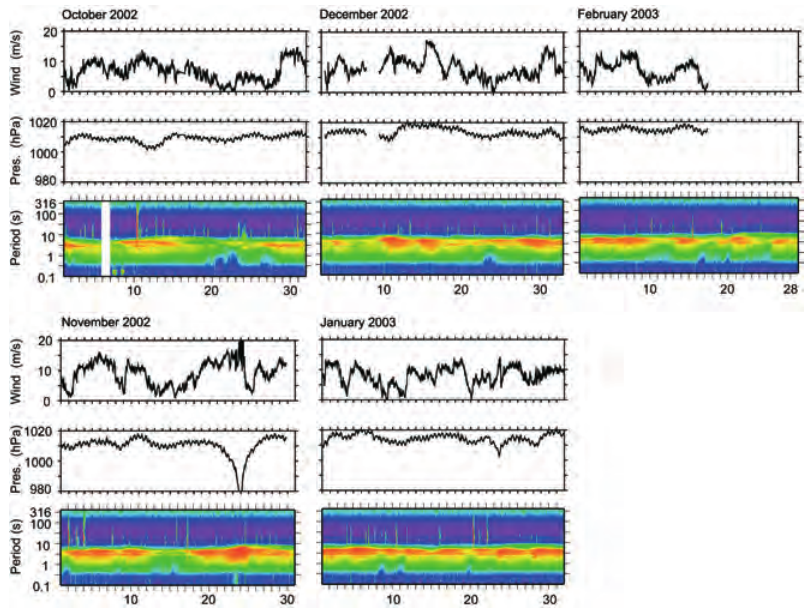
Fig. 9b. Comparison between the noise spectra of vertical component of the WP-1 and the meteorological da- ta (average wind speeds and air pressure) observed at Okinotori-shima, which lies about 150 km northeast of WP-1: from October 2002 to January 2003. Rapid decreases of air pressure indicates typhoon passing. The wind speed appears to be related to noise levels in periods around a few